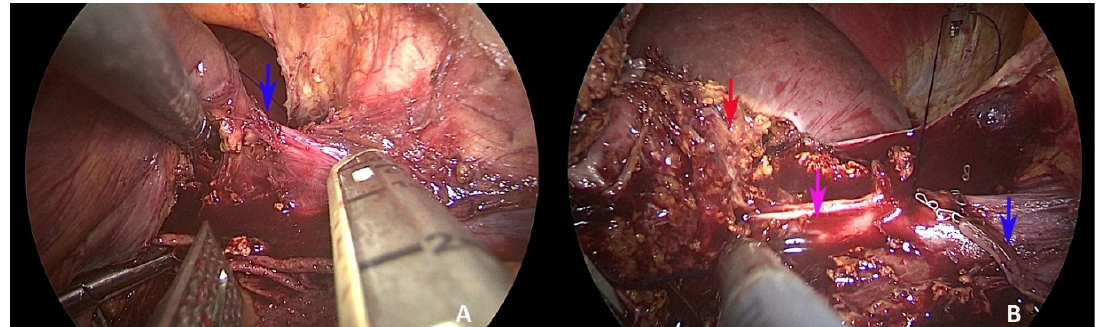
Figure 4. Exposure of the middle hepatic vein. ( A ) Insertion of the linear stapler from the bottom section of the left hepatic vein (blue arrow: left hepatic vein); ( B ) exposure of the middle hepatic vein after section of the left hepatic vein (blue arrow: left hepatic vein; violet arrow: middle hepatic vein; red arrow: liver metastasis).